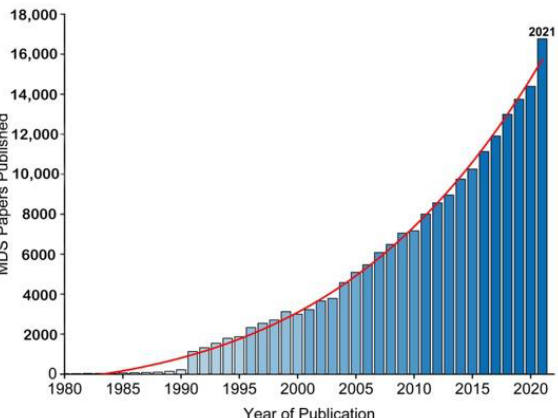
Figure 1. The growing use of MD Simulation studies over the years as reflected by publication (1980–2021). Data was from Web of Science.